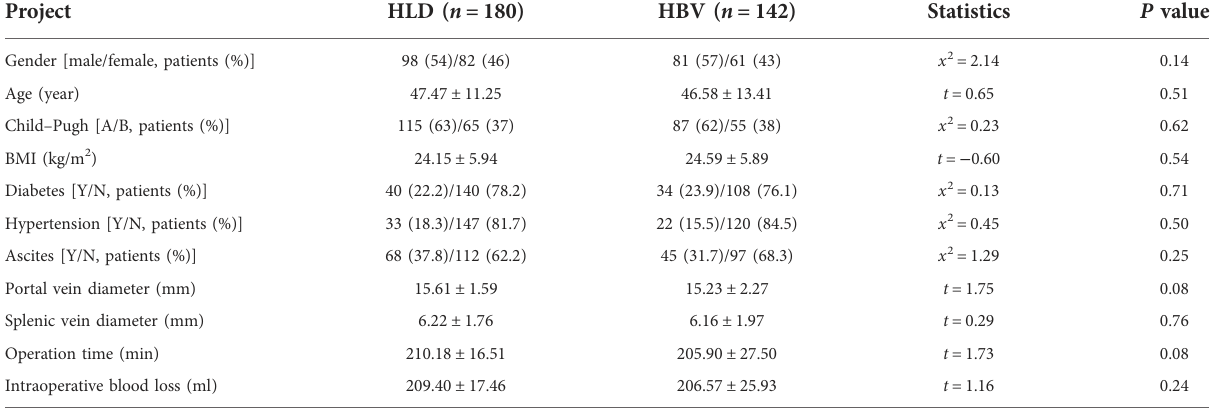
TABLE 1 Comparison of general data of the two groups of patients.